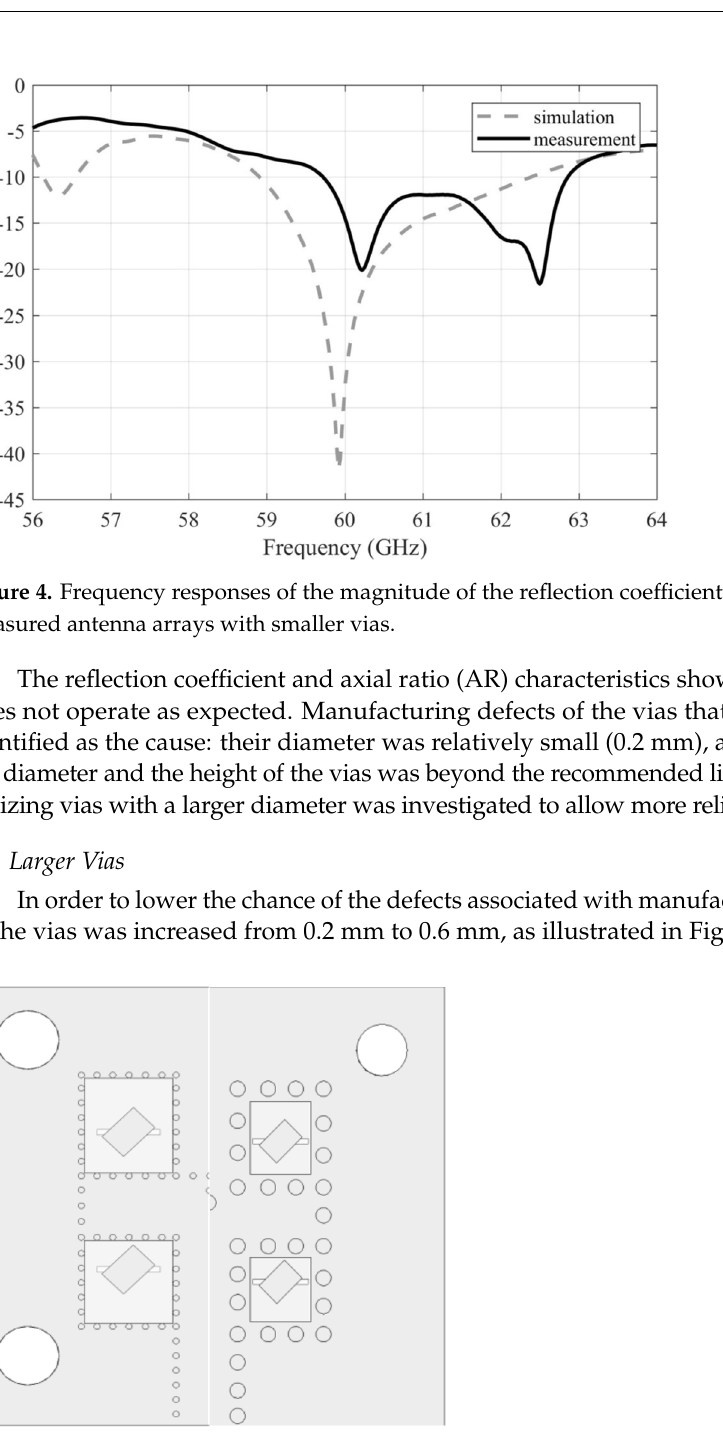
Figure 4. Frequency responses of the magnitude of the reflection coefficient for the simulated and measured antenna arrays with smaller vias.